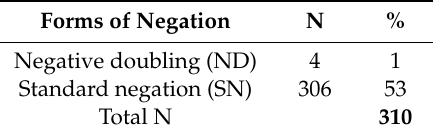
Table 2. Overall distribution of tokens (in absolute numbers and percentages) of negative doubling (ND) and standard negation (SN) in the elicited conversational speech. Forms of Negation N % Negative doubling (ND) 4 1 Standard negation (SN) 306 53 Total N